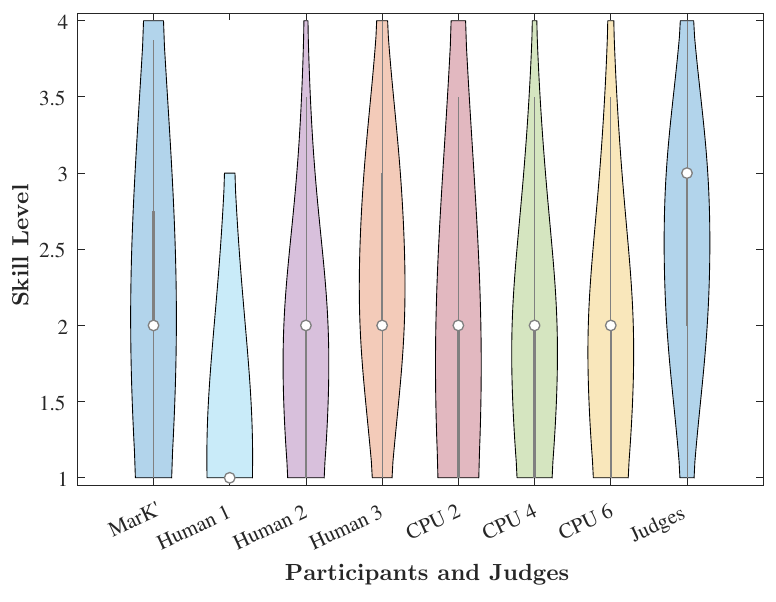
Figure 7. Third-person Turing test violin